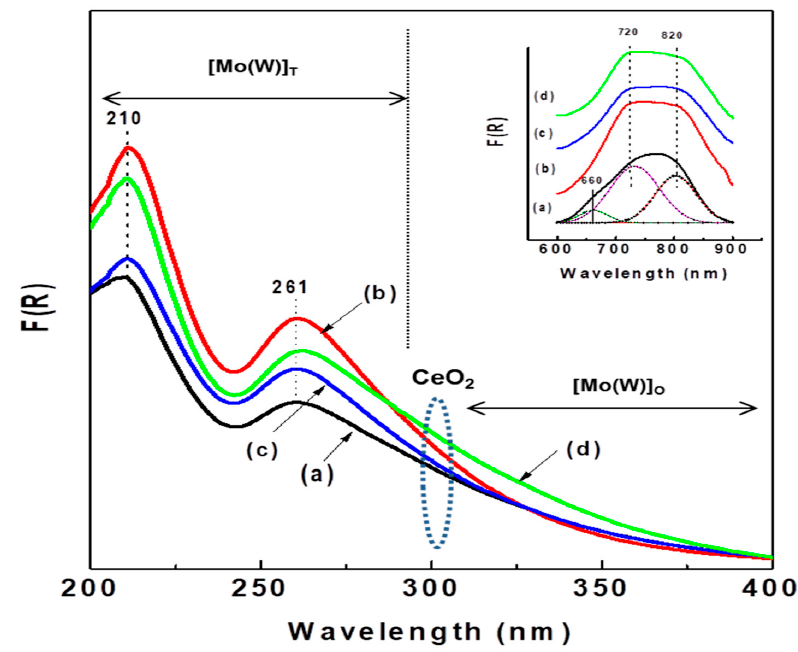
Figure 7. UV-diffuse reflectance spectra of calcined catalysts: ( a ) NiMoW/Al; ( b ) Figure 7 . UV ‐ diffuse reflectance spectra of calcined catalysts: (a) NiMoW/Al; (b) NiMoW/Al ‐ Ce5; (c) NiMoW/Al ‐ Ce10, and (d) NiMoW/Al ‐ Ce15.